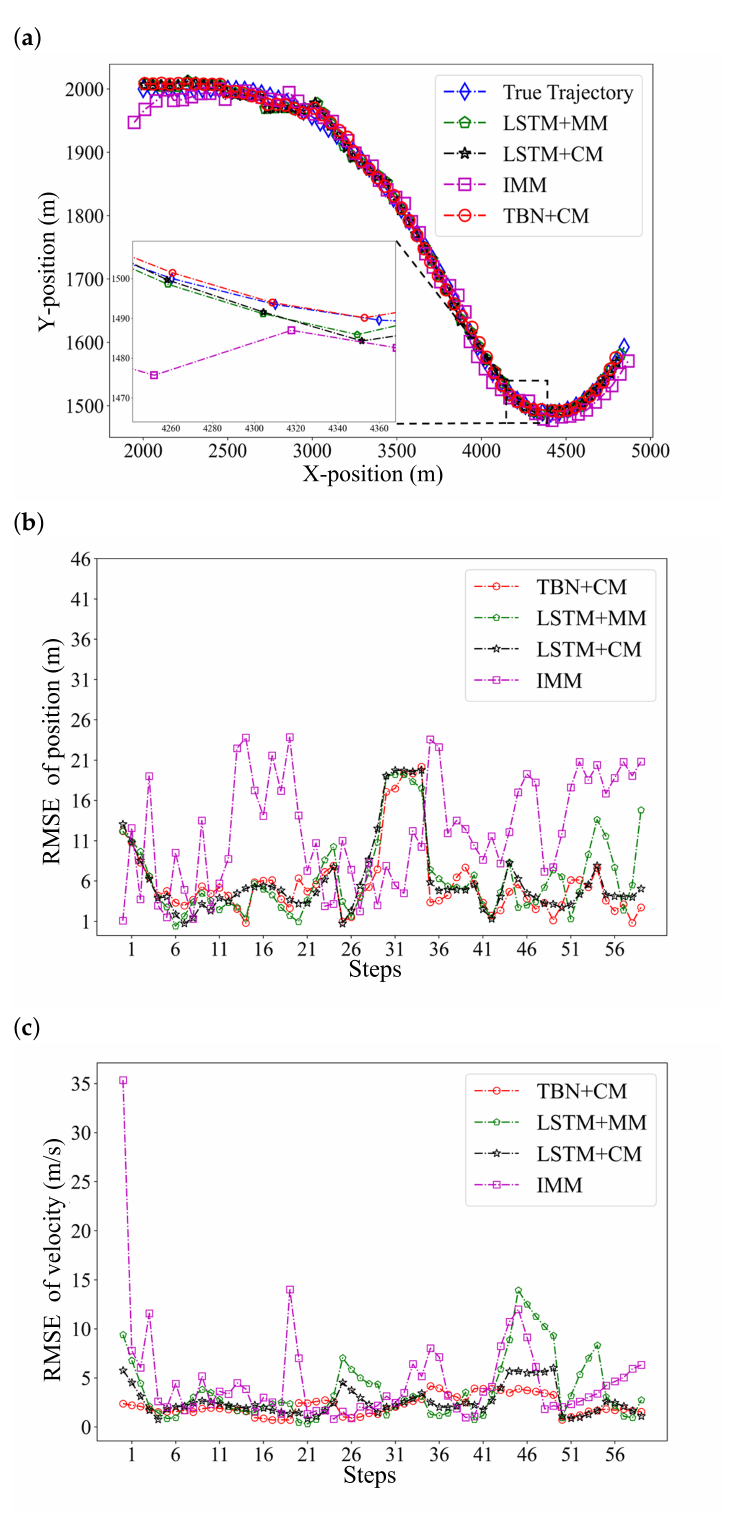
Figure 5. The result of tracking a maneuvering target by the TBM+CM, LSTM+MM, LSTM+CM, and IMM algorithms. ( a ) Tracking trajectory in the X-Y plane. ( b ) Pointwise position RMSE. ( c ) Pointwise velocity